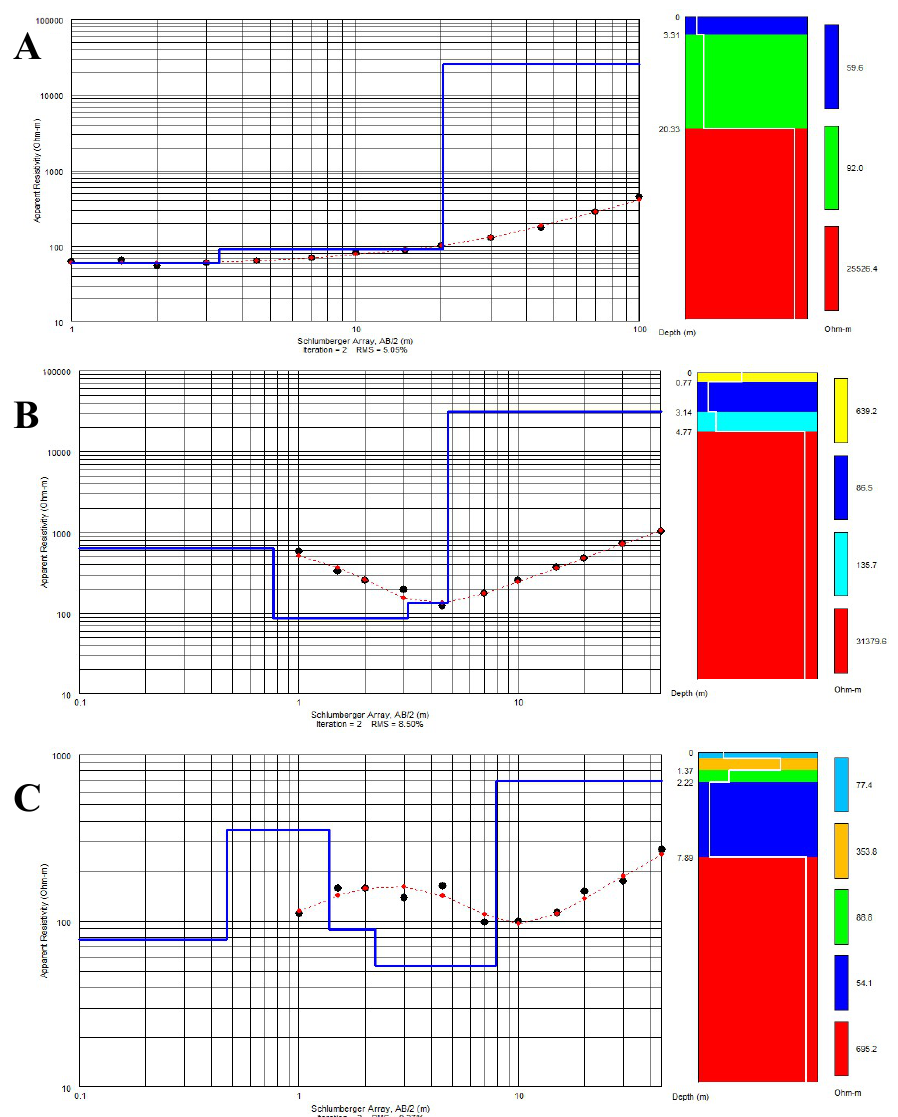
Figure 4. Samples of resistivity sounding curves obtained from the study site with their interpretations. ( A ) 3-layer curve model ( B ) 4-layer curve model ( C ) 5-layer curve model.